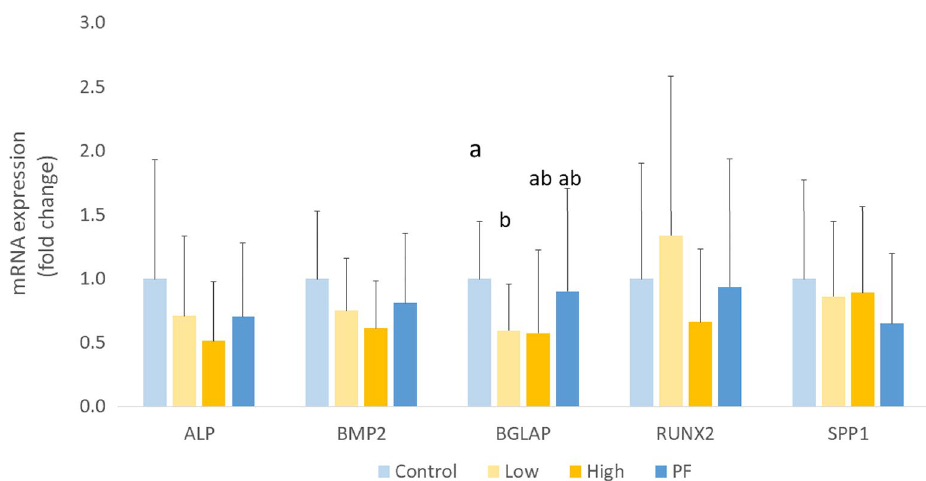
Figure 3. Osteogenesis-related gene expression in broilers bone marrow of different treatment groups. Control, non-challenge control group; Low, the low challenge dose of Eimeria ; High, the high challenge dosage of Eimeria ; PF, pair-feeding group that paired with High group. a,ab,b Treatments with different letters means a significantly difference between treatments by using Tukey’s HSD test, P = 0.002, N =